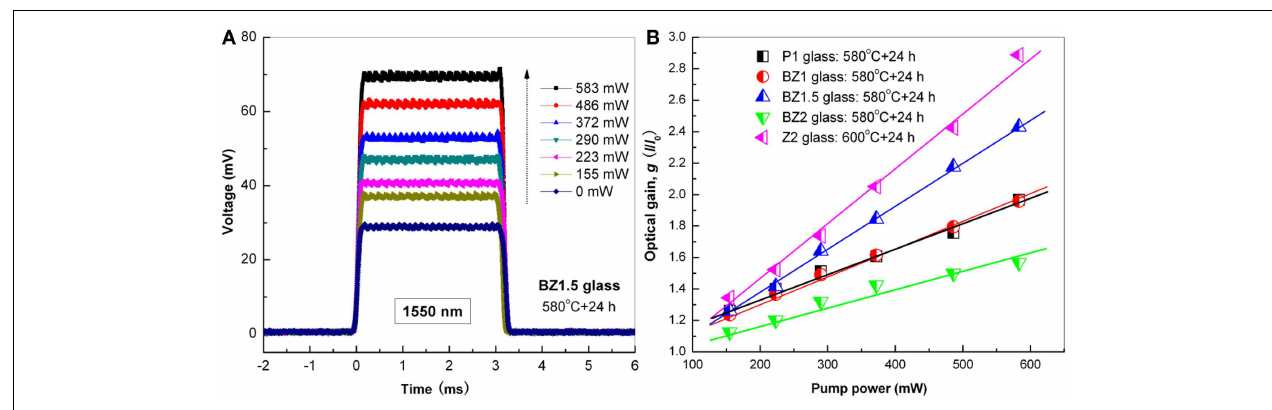
FIGURE 18 | (A) The amplified signals at 1550nm of PbS QD-doped glass heated at 580°C for 24h. (B) Optical gain ( I / I 0 ) at 1550nm of PbS QDs-doped glasses collected as a function of pumping power (Huang et al., in